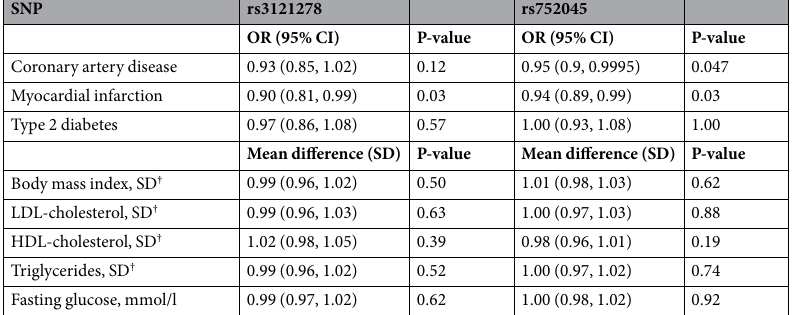
Table 2. Odds ratio (95% confidence interval) for coronary artery disease, myocardial infarction and type 2 diabetes, and mean difference (standard error) of cardiovascular risk factors per allele of SNPs used in Mendelian randomization analyses. SNP: single-nucleotide polymorphisms; OR: odds ratio; SD: standard deviation; LDL: low density lipoprotein; HDL: high density lipoprotein; † 1-SD equals to 4.5 kg/m 2 for BMI,